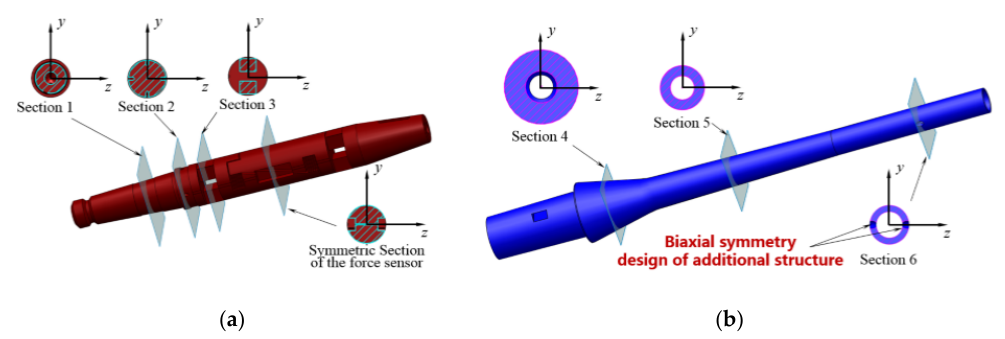
Figure 3. Structure characteristics of the cantilever support system. ( a ) Structure characteristics of wind tunnel balance. ( b ) Decoupling design of the cantilever sting.